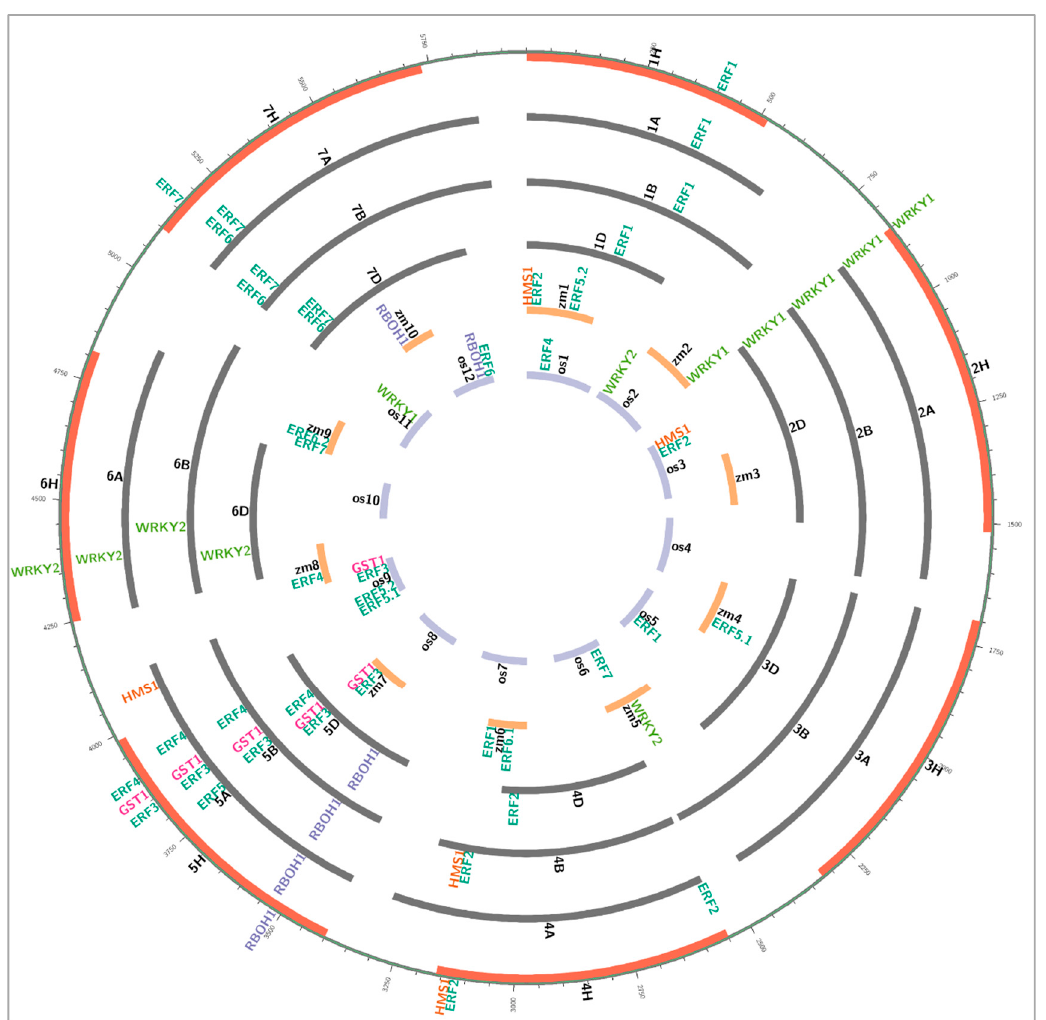
Figure 2. Homologous candidate genes for waterlogging tolerance in rice, maize, barley, and wheat. WRKY: WRKY transcription factor family, GST: glutathione S transferase, RBOH: respiratory burst oxidase homolog, HMS: heavy metal transport/detoxification superfamily protein, ERF: Ethylene-responsive factor. Each bar represents the individual chromo- some, and the chromosome name is placed in the middle of the bar. The purple bars indicate 12 chromosomes of rice; the orange bars indicate 10 chromosomes of maize; the grey bars indicate 7 chromosomes of wheat A, B, D genome; the red bars indicate 7 chromosomes of barley. Gene name placed on the chromosome bar based on the physical position.